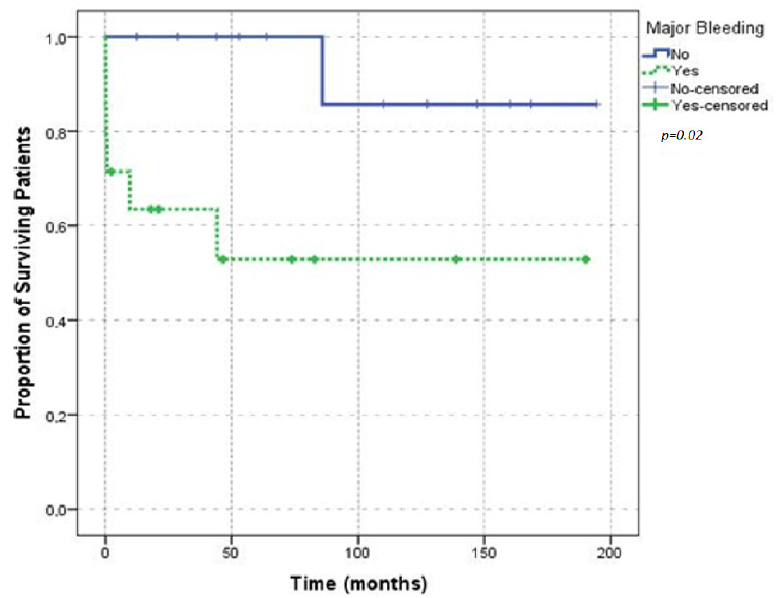
Figure 7. Overall survival according to major bleeding.